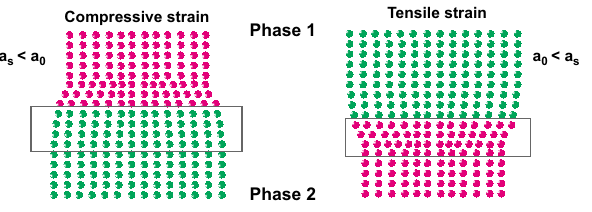
Fig. 4 Compressive strain and tensile strain at the